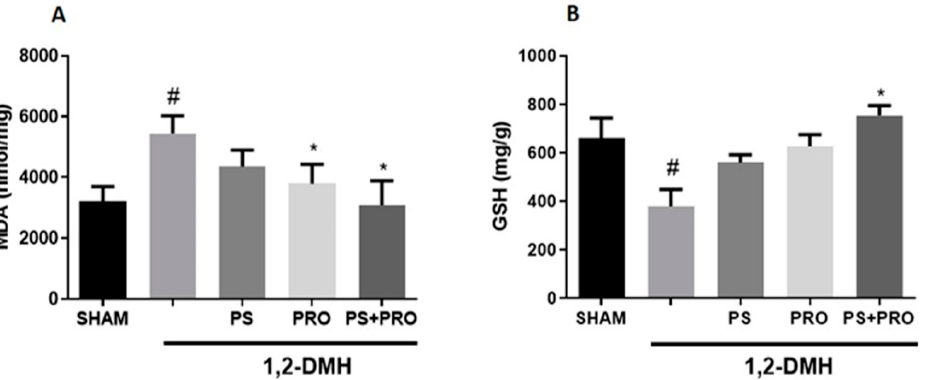
Figure 3. Analysis of oxidative damage by measuring MDA and GSH levels in the distal colon segment. ( A ) MDA and GSH ( B ) levels in the distal colon segment. The values are presented as the mean ± SEM. # p < 0.05 vs. Sham and * p < 0.05 vs. 1,2-DMH group. For statistical analysis, the one-way ANOVA test was used followed by Tukey’s post-test.